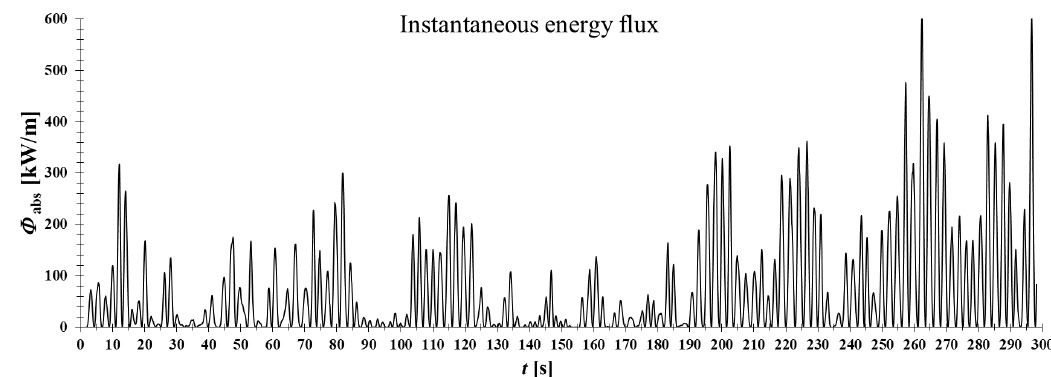
Figure 9. The instantaneous energy flux absorbed by the U-OWC, during the same time intervals shown in Figure